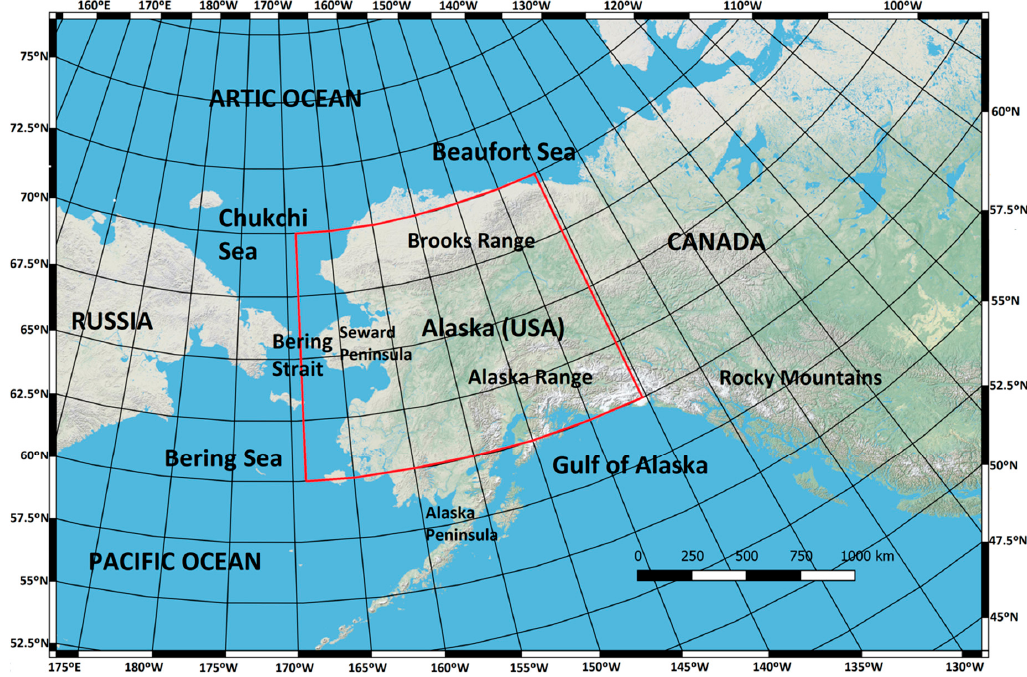
Figure 1. The study region includes the entire boreal forest of Alaska (70° N–60° N, 168.5° W–141° W).